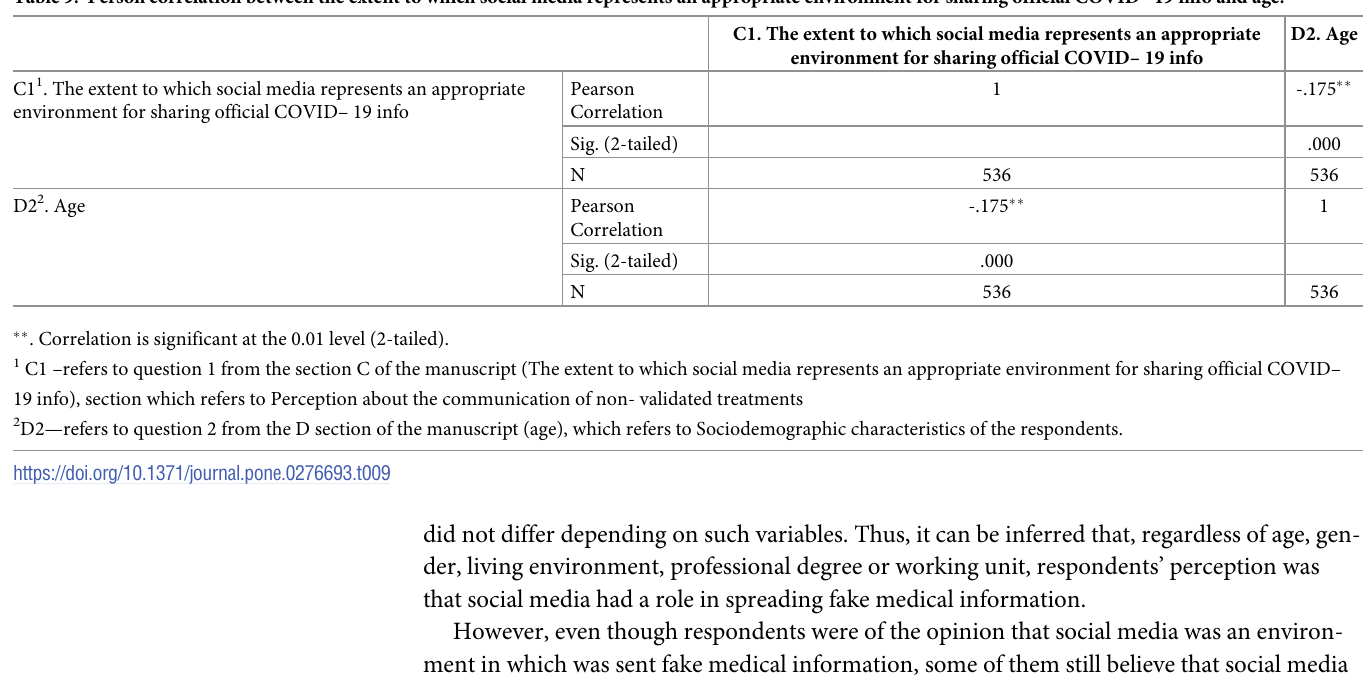
Table 9. Person correlation between the extent to which social media represents an appropriate environment for sharing official COVID– 19 info and